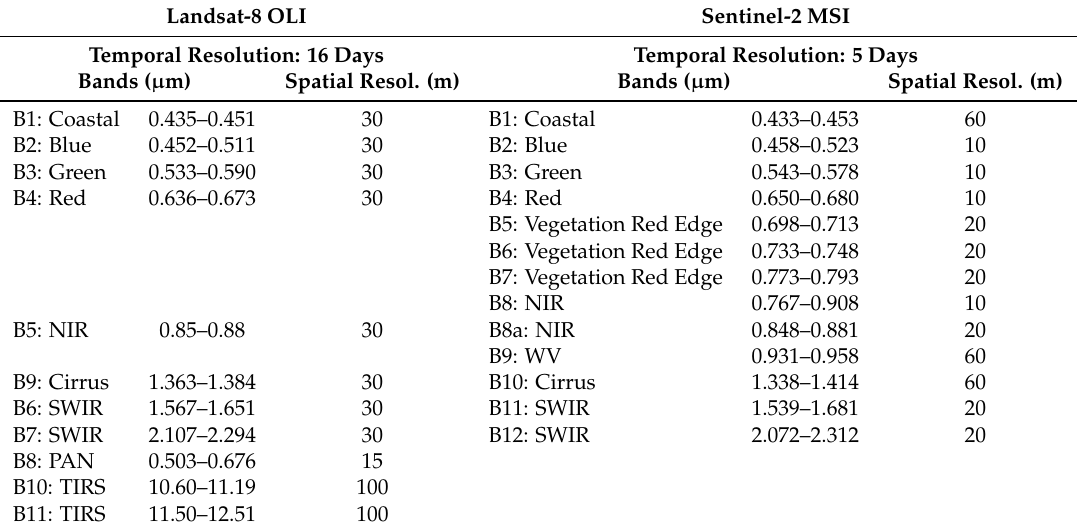
Table 1. Technical characteristics of the Landsat-8 ( L 8) and Sentinel-2 ( S 2) satellite